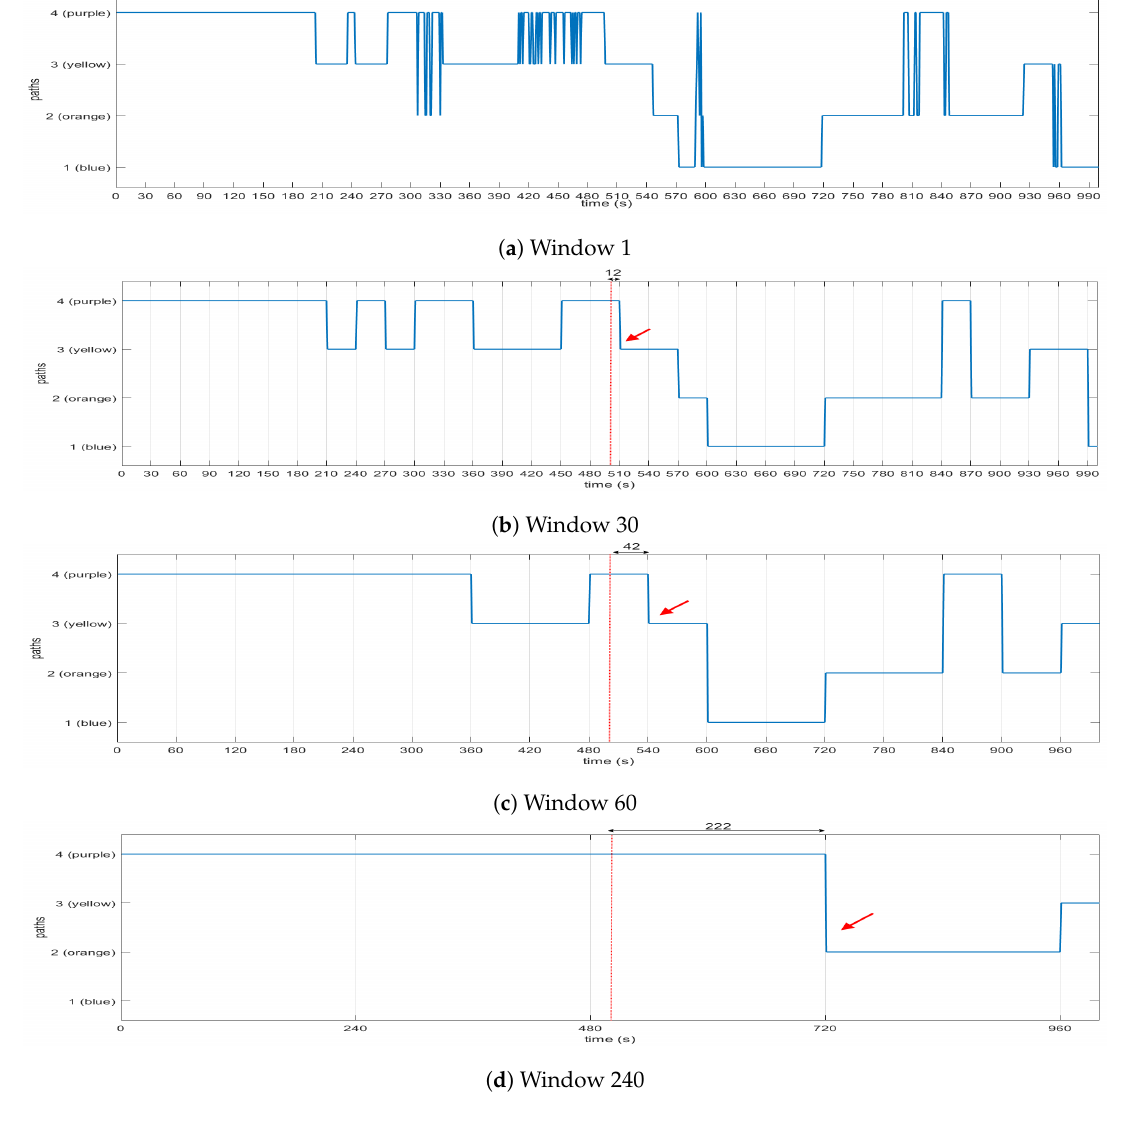
Figure 24. Selected path with different